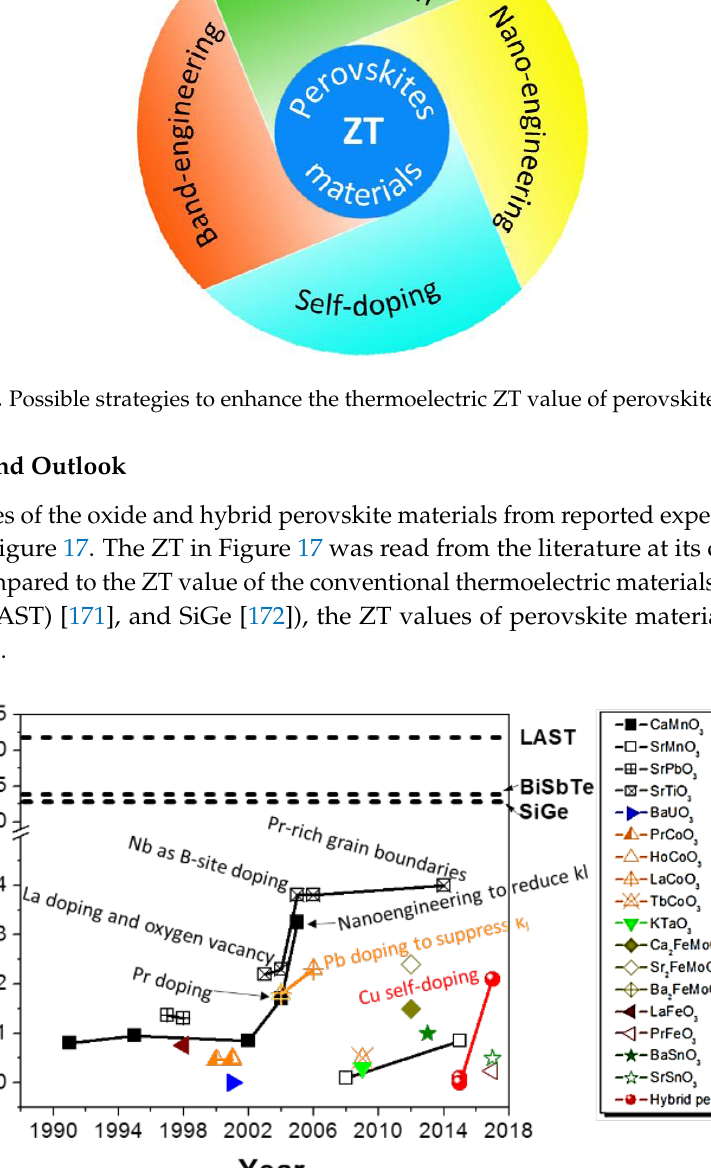
Figure 17. Summary of thermoelectric ZT values of oxide and hybrid perovskite materials by year. The three dashed lines are the ZT value of BiSbTe [163], AgPb 18 SbTe 20 (LAST) [171], and SiGe [172], which have a different optimum working temperature. The thermoelectric ZT values of all materials were extracted from literature at its optimum working temperature.